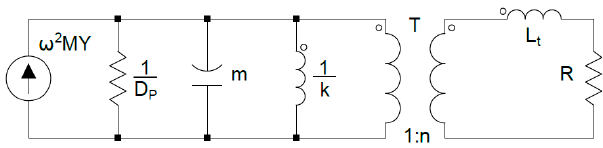
Figure 9. Equivalent circuit of an electromagnetic force harvester.